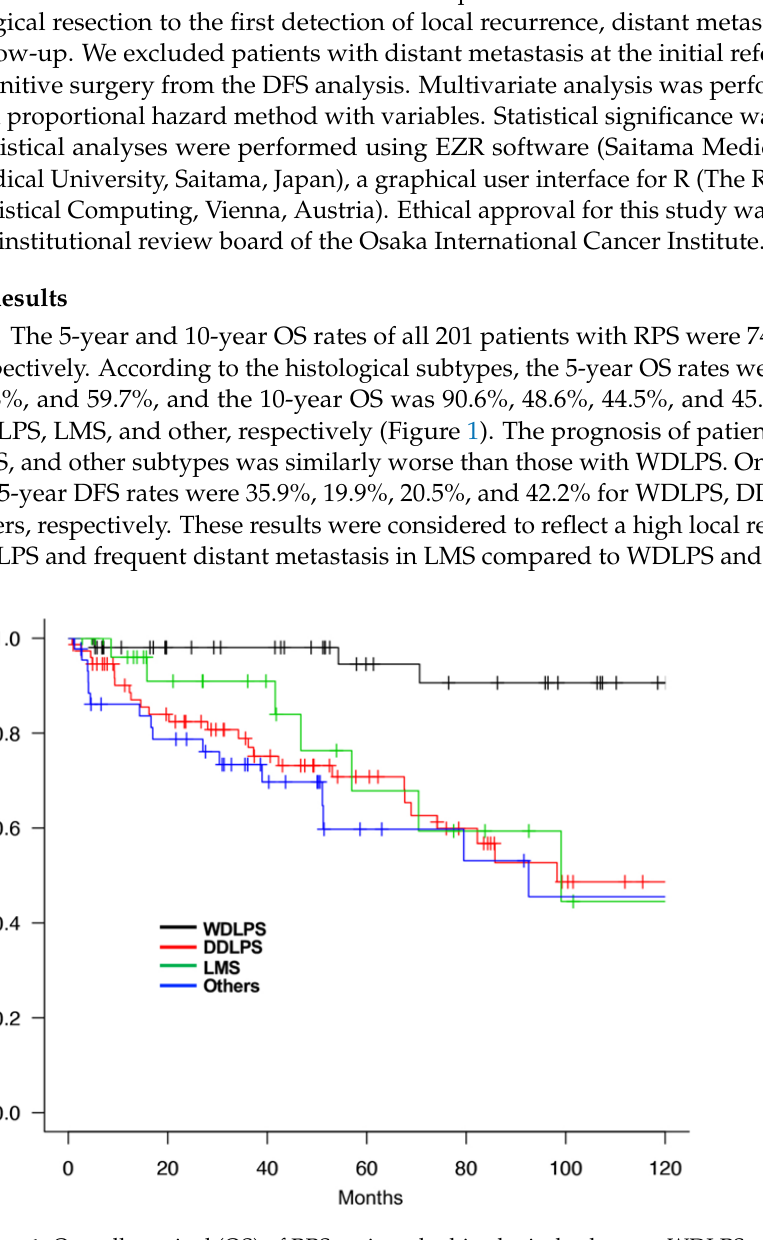
Figure 1. Overall survival (OS) of RPS patients by histological subtypes. WDLPS; well-differentiated liposarcoma, DDLPS; dedifferentiated liposarcoma, LMS; leiomyosarcoma. We used the SUVmax threshold of 4 because this threshold was the median score of all patients with RPS in this study, and the prognosis of each group was the most significant with this setting. The 5-year OS of the SUVmax low (<4) and SUVmax high ( ≥ 4) groups were 92.9% and 58.4%, respectively, showing that the SUVmax was a strong prognostic factor for RPS ( p < 0.001, Figure 2a). Furthermore, the 5-year DFS rates of the SUVmax low and SUVmax high groups were 34.5% and 12.7%, respectively ( p = 0.027, Figure 2b). In addition, we compared the characteristics of the patients in the low- and high SU- Vmax groups. Most of the patients with Grade1 tumors had low SUVmax (83.3%, 35 out of 42), and most of the patients with Grade3 tumors had high SUVmax (92.6%, 25 out of 27). However, patients with Grade2 tumors were recruited in both SUVmax low and SU- Vmax high groups (Table 2). After that, we compared patient prognosis in the SUVmax low and SUVmax high groups by stratification with tumor Grade. It showed that patients with high SUVmax and Grade2 tumors had poor prognosis compared to those with low SUVmax and Grade2 tumors, and patients with high SUVmax and Grade3 tumors showed the poorest prognosis. There were insufficient numbers of patients with low SU- Vmax and Grade3 tumors or high SUVmax and Grade1 tumors for the abovementioned comparisons. (Figure 2c). These results suggested that SUVmax was a strong prognostic factor of at least Grade2 tumors in RPS. Table 2. Clinicopathologic and treatment characteristics between SUVmax low and SUVmax high. Characteristic SUVmax Low ( n = 72) SUVmax High ( n = 73) p Value Age, years (Range, median)